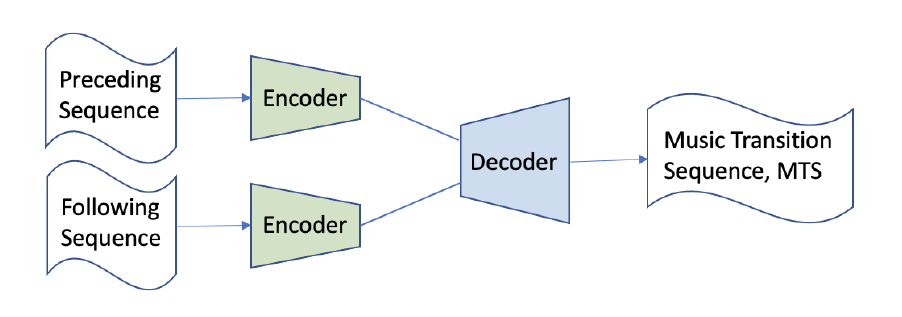
Figure 10. Encoder–Decoder